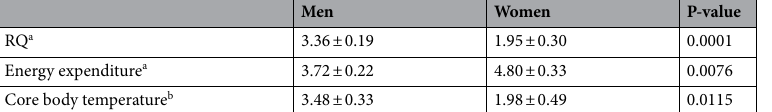
Table 2. Nadir of body temperature, RQ and energy expenditure during sleep in men and women. Time of the nadir (5-min period of the lowest value) was shown as time after bedtime in hours for RQ, energy expenditure and body temperature. Bedtime of each experiment was 23:00 18–22 or at subjects’ habitual bedtime (23:00–24:30) 8,23–25 . In studies with an 8-h sleep opportunity, data of the first 7 h was included for statistical analysis 8,23–25 . The nadir of the RQ (P = 0.608), energy expenditure (P = 0.858) and body temperature (P = 0.310) during sleep in women was not related to their menstrual cycle. a Mean age of the men (n = 79, 24.5 ± 0.5 years) and women (n = 36, 23.4 ± 0.3 years) were comparable (P = 0.169) 8,18–25 . b Mean age of the men (n = 30,